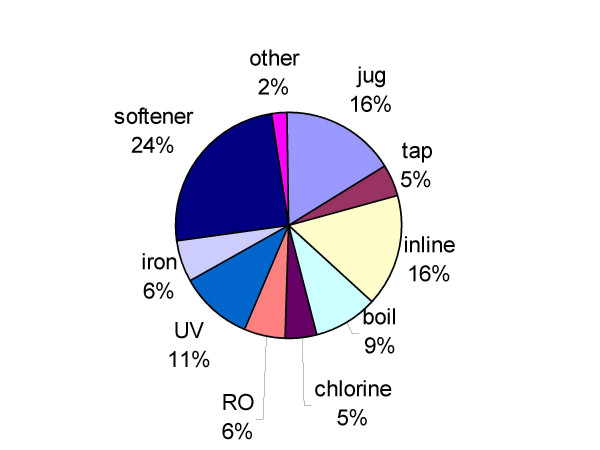
Frequency distribution of 266 treatment devices used to treat private water supplies (City of Hamilton, Ontario, 2004) (n = 130 households)* Jug = jug filter (e.g. Brita filter) Tap = tap filter Inline = inline filter Boil = boiling Chlorine = chlorine added RO = reverse osmosis UV = ultraviolet light Iron = iron removal device Softener = water softener Other = other device * Total number of devices exceeds total number of respondents because of multiple devices per respondent